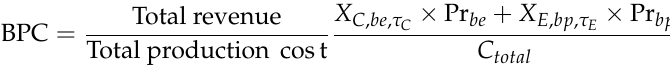
Table 3. Inputs costs and output prices in bioethanol production